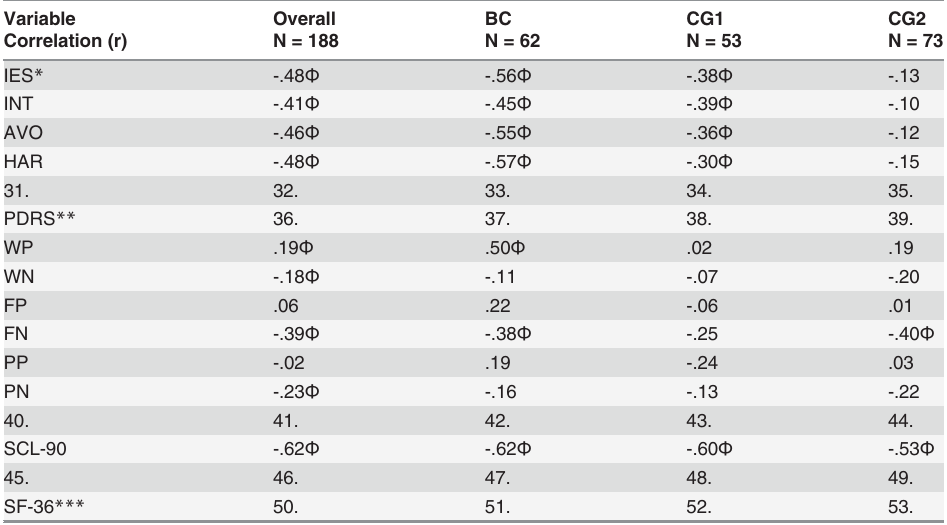
Table 4. Overall and subgroup relations between quality of life, distress, traumatic stress, and post deployment reintegration. Variable